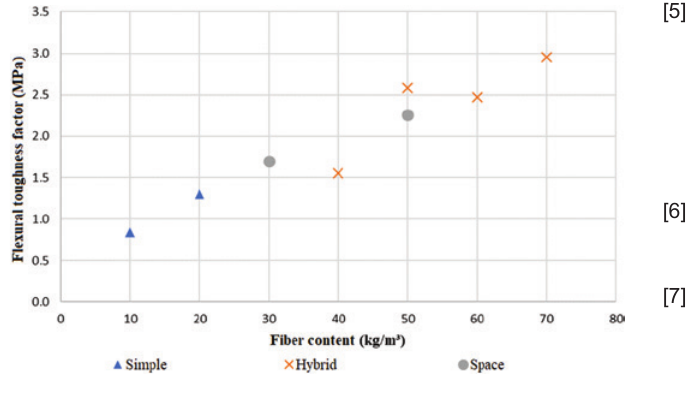
Increase of fiber content and flexural toughness